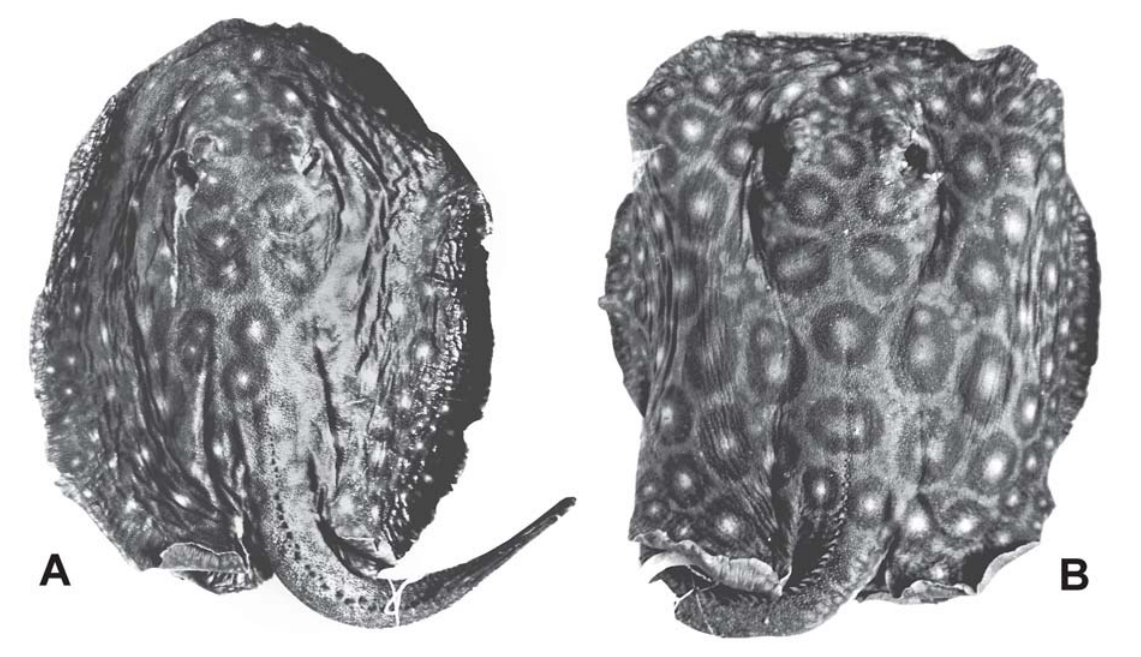
Fig. 6. Potamotrygon boesemani . Dorsal views of non-type specimens (RMNH 26188), from Corantijn river: ( A ) 275 mm DW; ( B ) 364 mm DW.